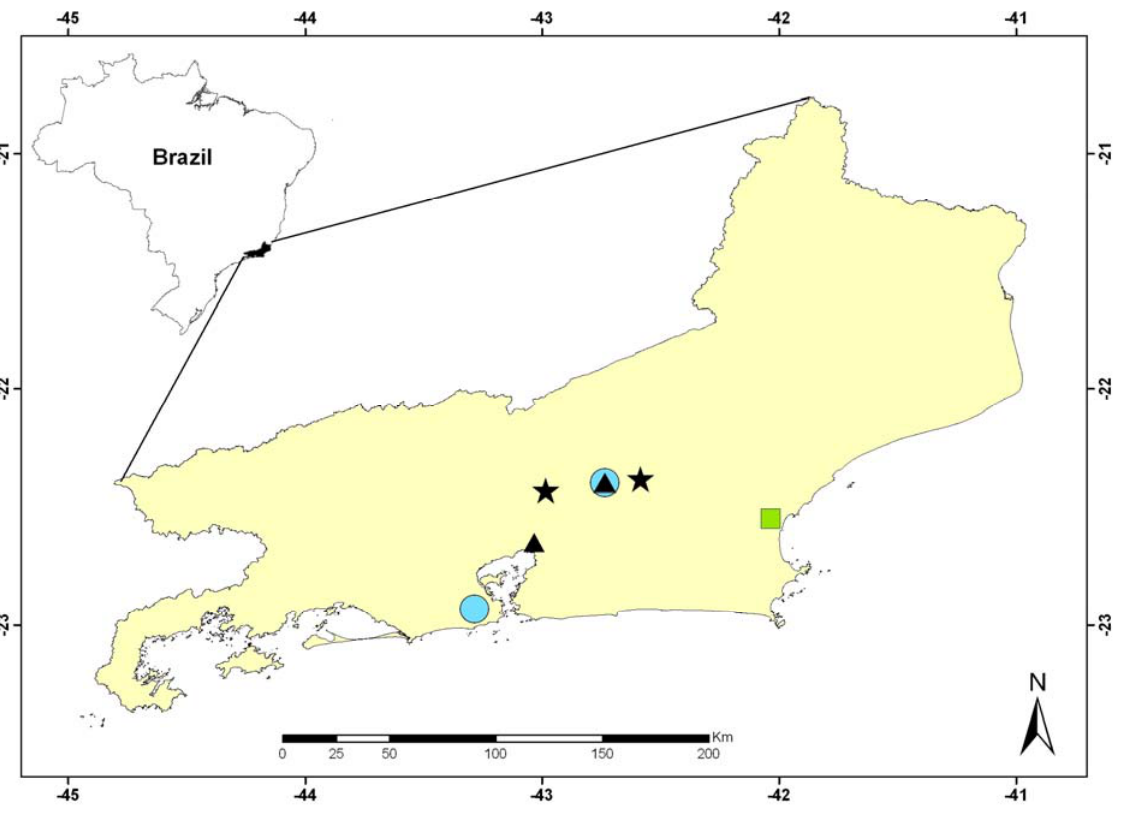
Figure 2 . Map of the state of Rio de Janeiro showing the previous known records of Hylodes charadranaetes (stars) Ischnocnema octavioi (blue circles) and Euparkerella cochranae (triangles), and the new record for these three species at Morro São João (green